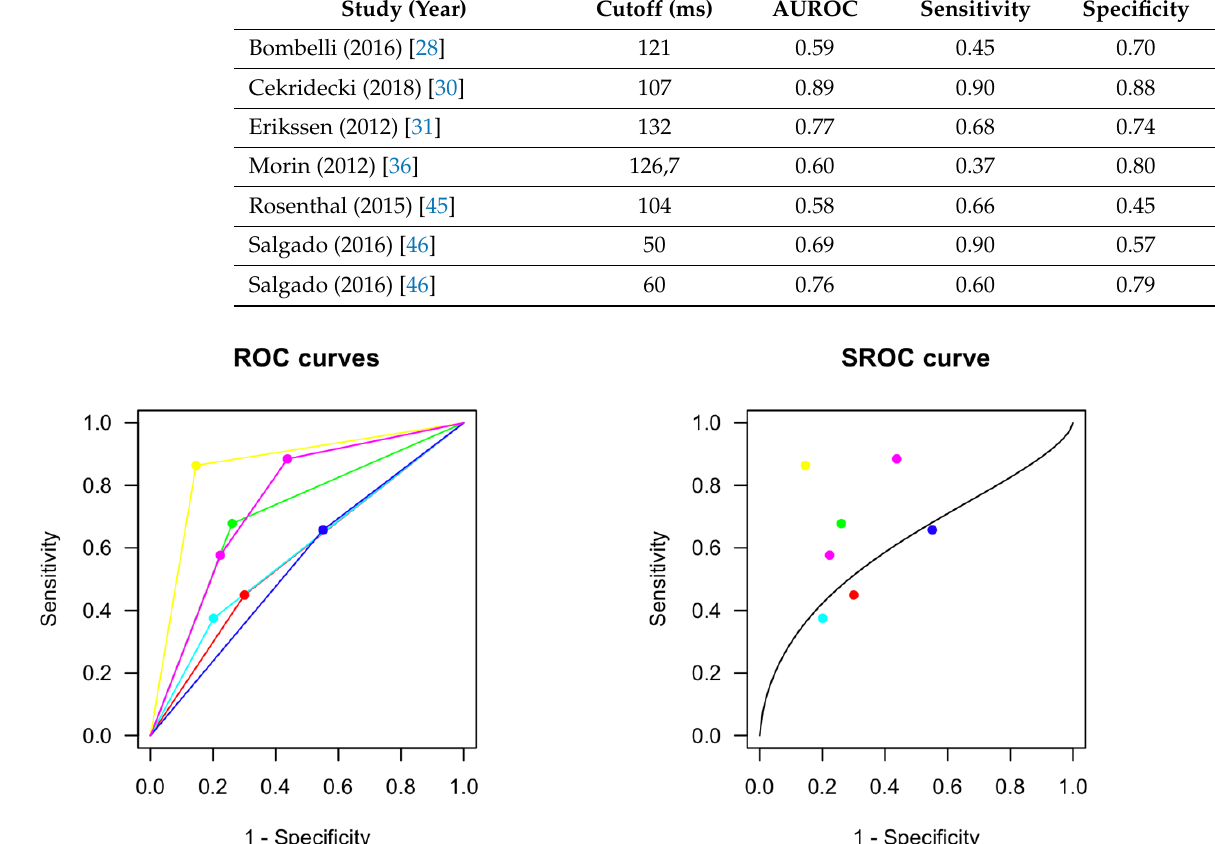
Figure 6. Estimated receiver operating characteristics of the seven reported AUROCS with corre- sponding sensitivity and specificity ( left ) and the estimated summary ROC (SROC) curve with an AUC of 0.65 ( right ). (Bombelli (2016) [28] (red); Cekridecki (2018) [30] (yellow); Erikssen (2012) [31] (green); Morin (2012) [36] (light blue); Rosenthal (2015) [45] (dark blue); Salgado (2016) [46] (pink)).